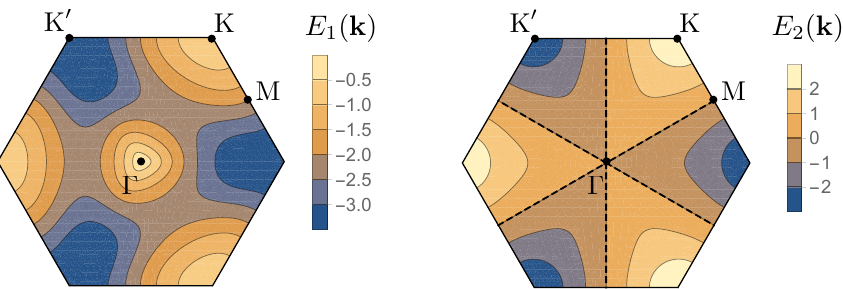
( k ) in the QSL with Abrikosov fermions, No. 11 in n = t = 0.7, t = i . Symmetry d 1 2 ( k ) = − E ( − k ) . Fermi surfaces are indicated by 3 1